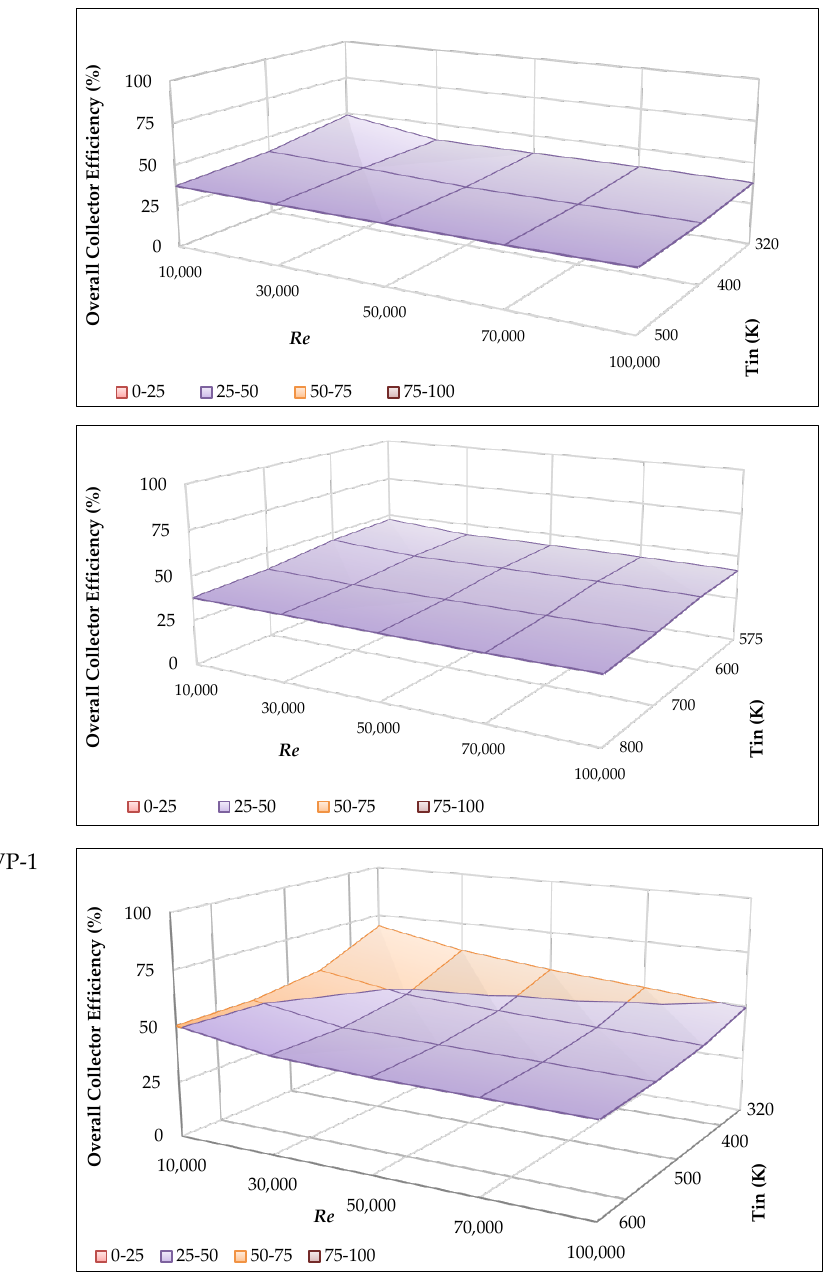
Figure 10. Thermal e ffi ciency behaviour of all heat transfer fluids under di ff erent parameters.